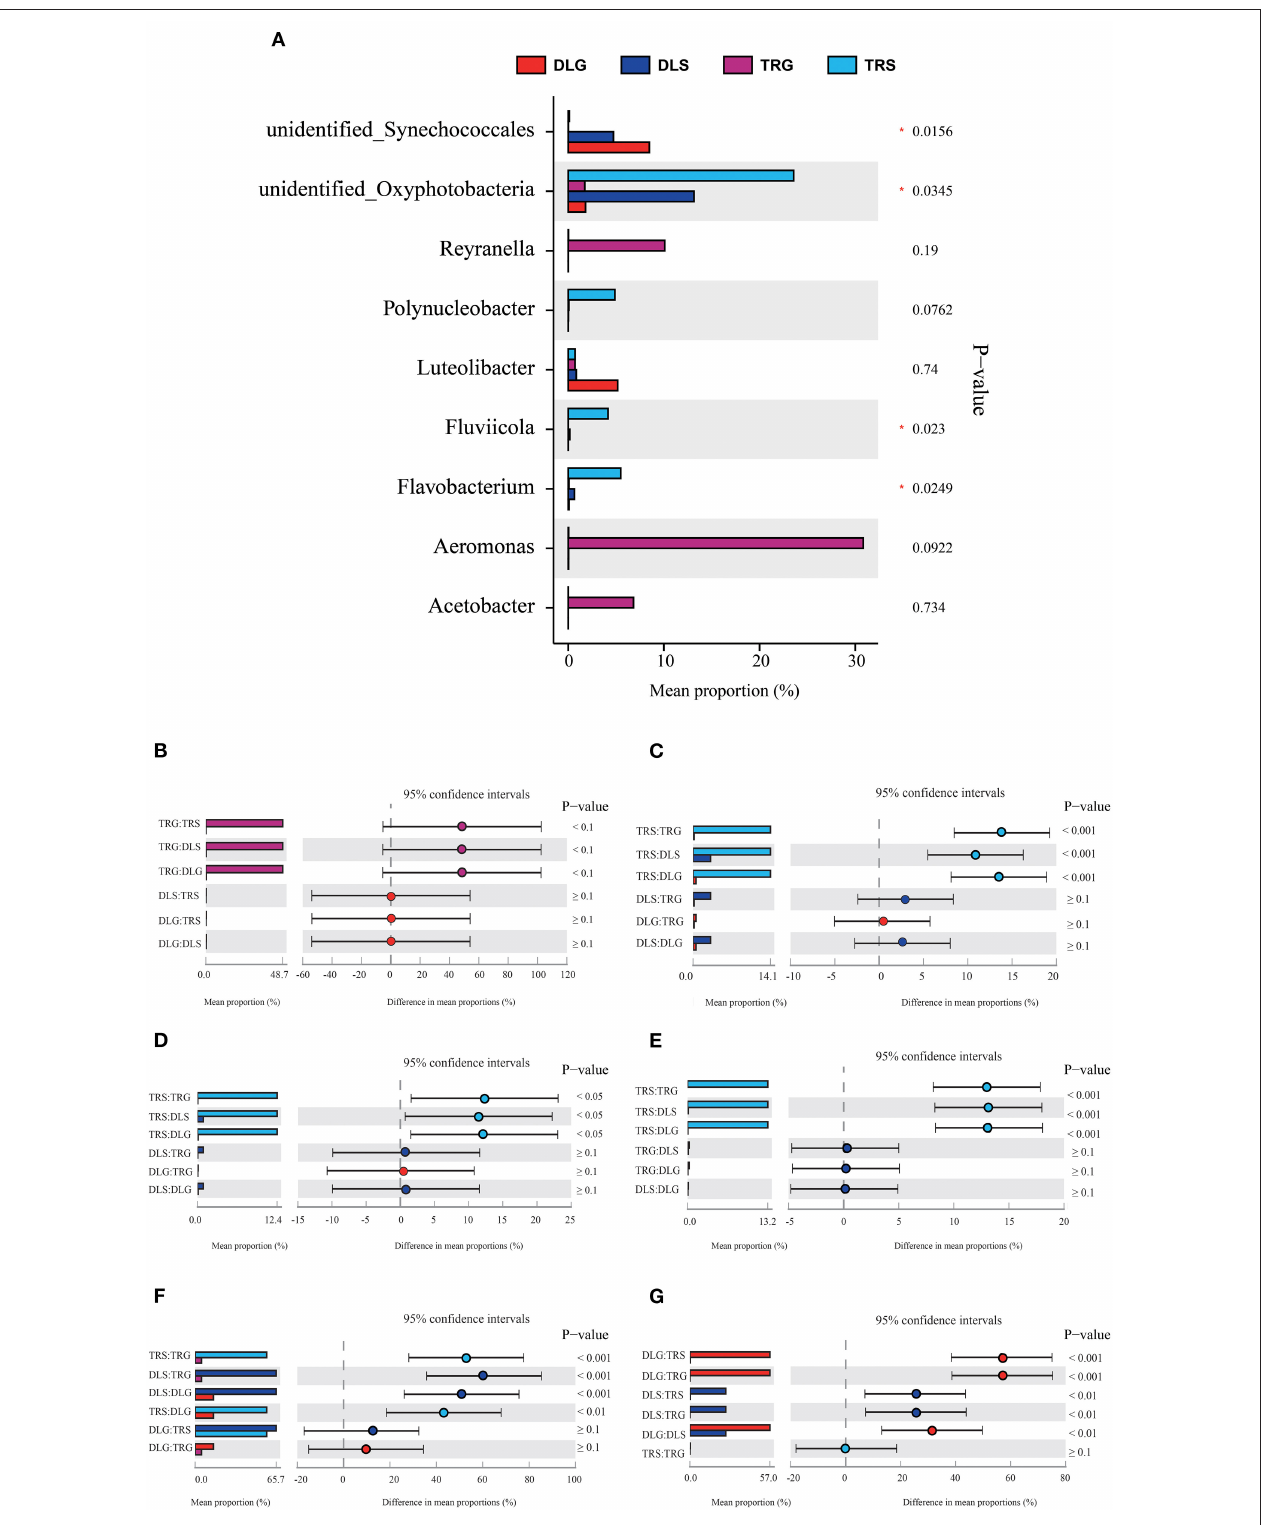
FIGURE 5 | Comparison of bacterial abundances in intestine and water at the alkaline water and freshwater environment at the genus level (A) . One-way ANOVA bar plot on genus level for Aeromonas (B) , Flavobacterium (C) , Fluviicola (D) , Polynucleobacter (E) , unidentified_Synechococcales (F) , and unidentified_ Oxyphotobacteria (G) . * stands for 0.01< P ≤ 0.05.